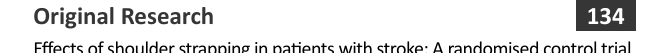
The efficacy of kinesiology taping for improving gross motor function in children with cerebral palsy: A systematic